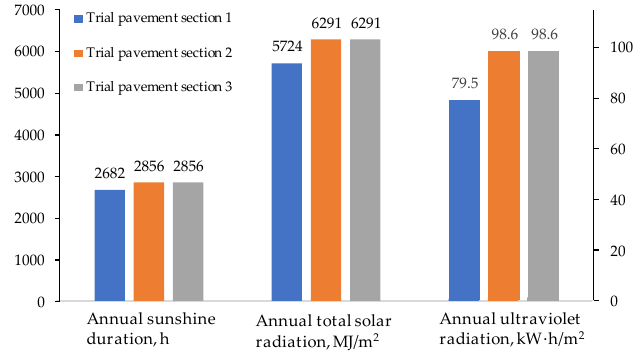
Figure 13. The comparison of UV radiation in three trial sections.